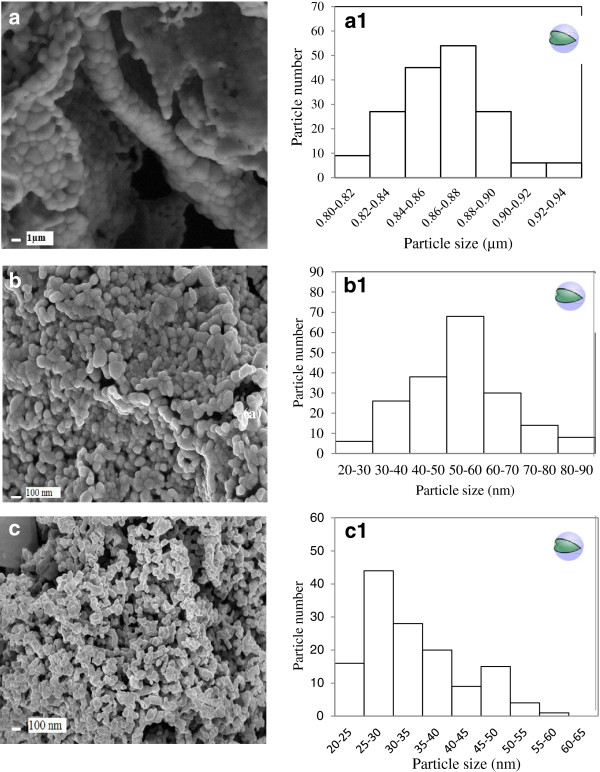
FESEM micrographs the metal tungstates and the calculated particle size distributions. BaWO4 (a) (a1), NiWO4 (b) (b1), Bi2WO6 (c) (c1).